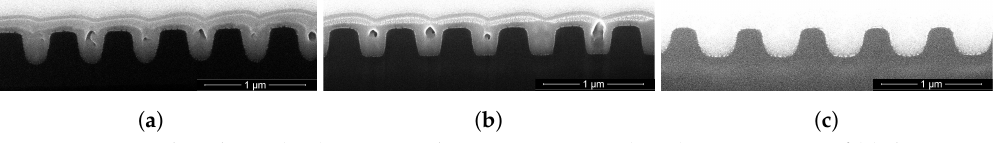
Figure 14. Focused ion beam (FIB) scanning electron microscope (SEM) cross sections of ( a ) the master GMR grating in AZ nLOF, ( b ) the imprinted GMR grating in OrmoCore, ( c ) the imprinted GMR grating in EpoCore. Table 4. The measured GMR grating properties of the master in AZ nLOF and the imprinted gratings in OrmoCore and EpoCore in Figure